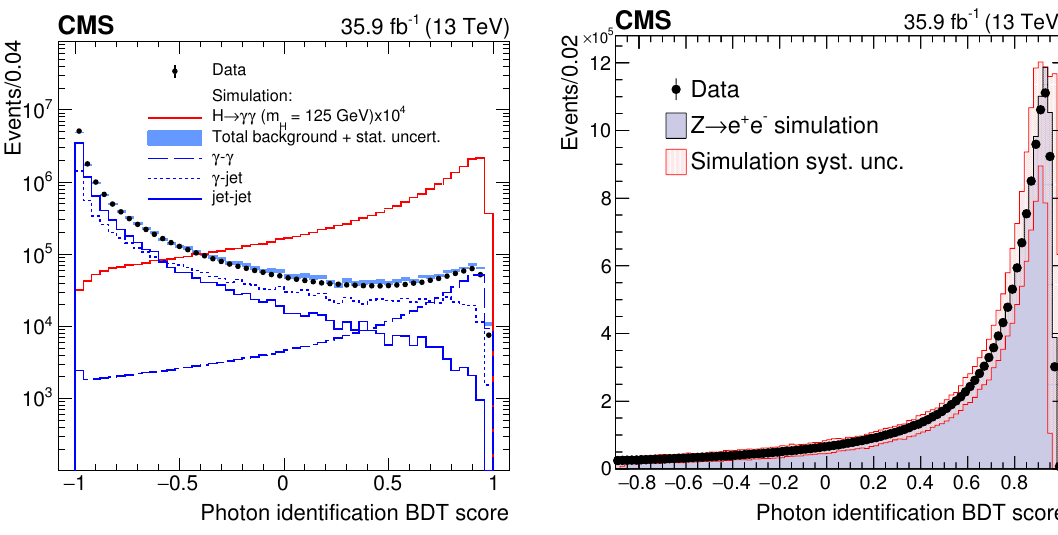
Figure 2 . (Left) Distribution of the photon identi(cid:12)cation BDT score of the lowest scoring photon of diphoton pairs with an invariant mass in the range 100 < m (cid:13)(cid:13) < 180 GeV, for events passing the preselection in the 13 TeV data set (points), and for simulated background events (blue histogram). Histograms are also shown for di(cid:11)erent components of the simulated background. The sum of all background distributions is scaled up to data. The red histogram corresponds to simulated Higgs boson signal events. (Right) Distribution of the photon identi(cid:12)cation BDT score for Z ! e + e (cid:0) events in data and simulation, where the electrons are reconstructed as photons. The systematic uncertainty applied to the shape from simulation (hashed region) is also